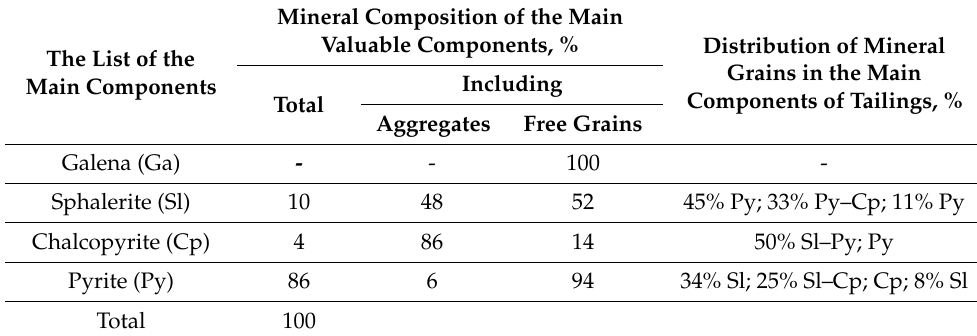
Table 4. Mineral composition of the sample of old enrichment